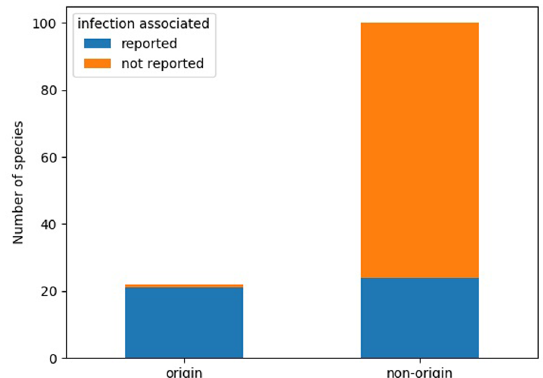
Fig. 4 Association with infection for randomly selected Proteobacteria and origin species. Grouped barchart showing number of species reported in infection for origin and non-origin species ( n = 122). Non-origin species were randomly selected from all proteobacterial species in the NCBI Assembly